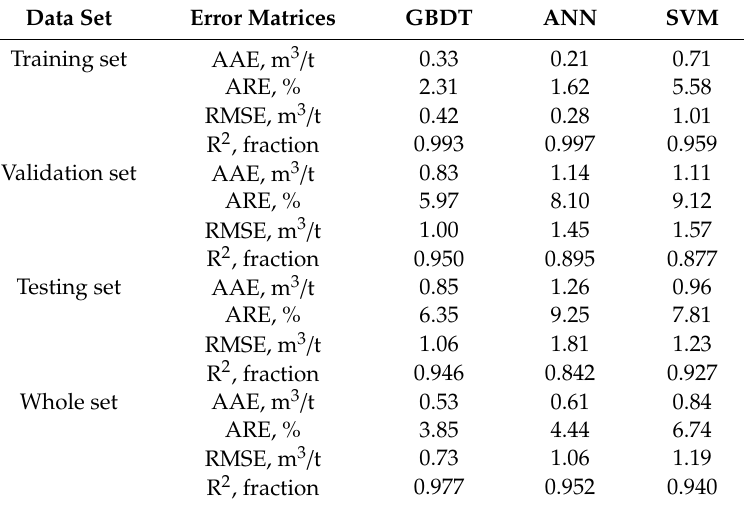
Figure 6. Cross plot of the gradient boosting decision trees (GBDT) estimated versus measured adsorption amount for the ( a ) training ( b ) validation; and, ( c ) testing sets. Open circles are data points; red lines are 45-degree lines. Table 3. Error statistics of the GBDT, BP-ANN, and SVM models.